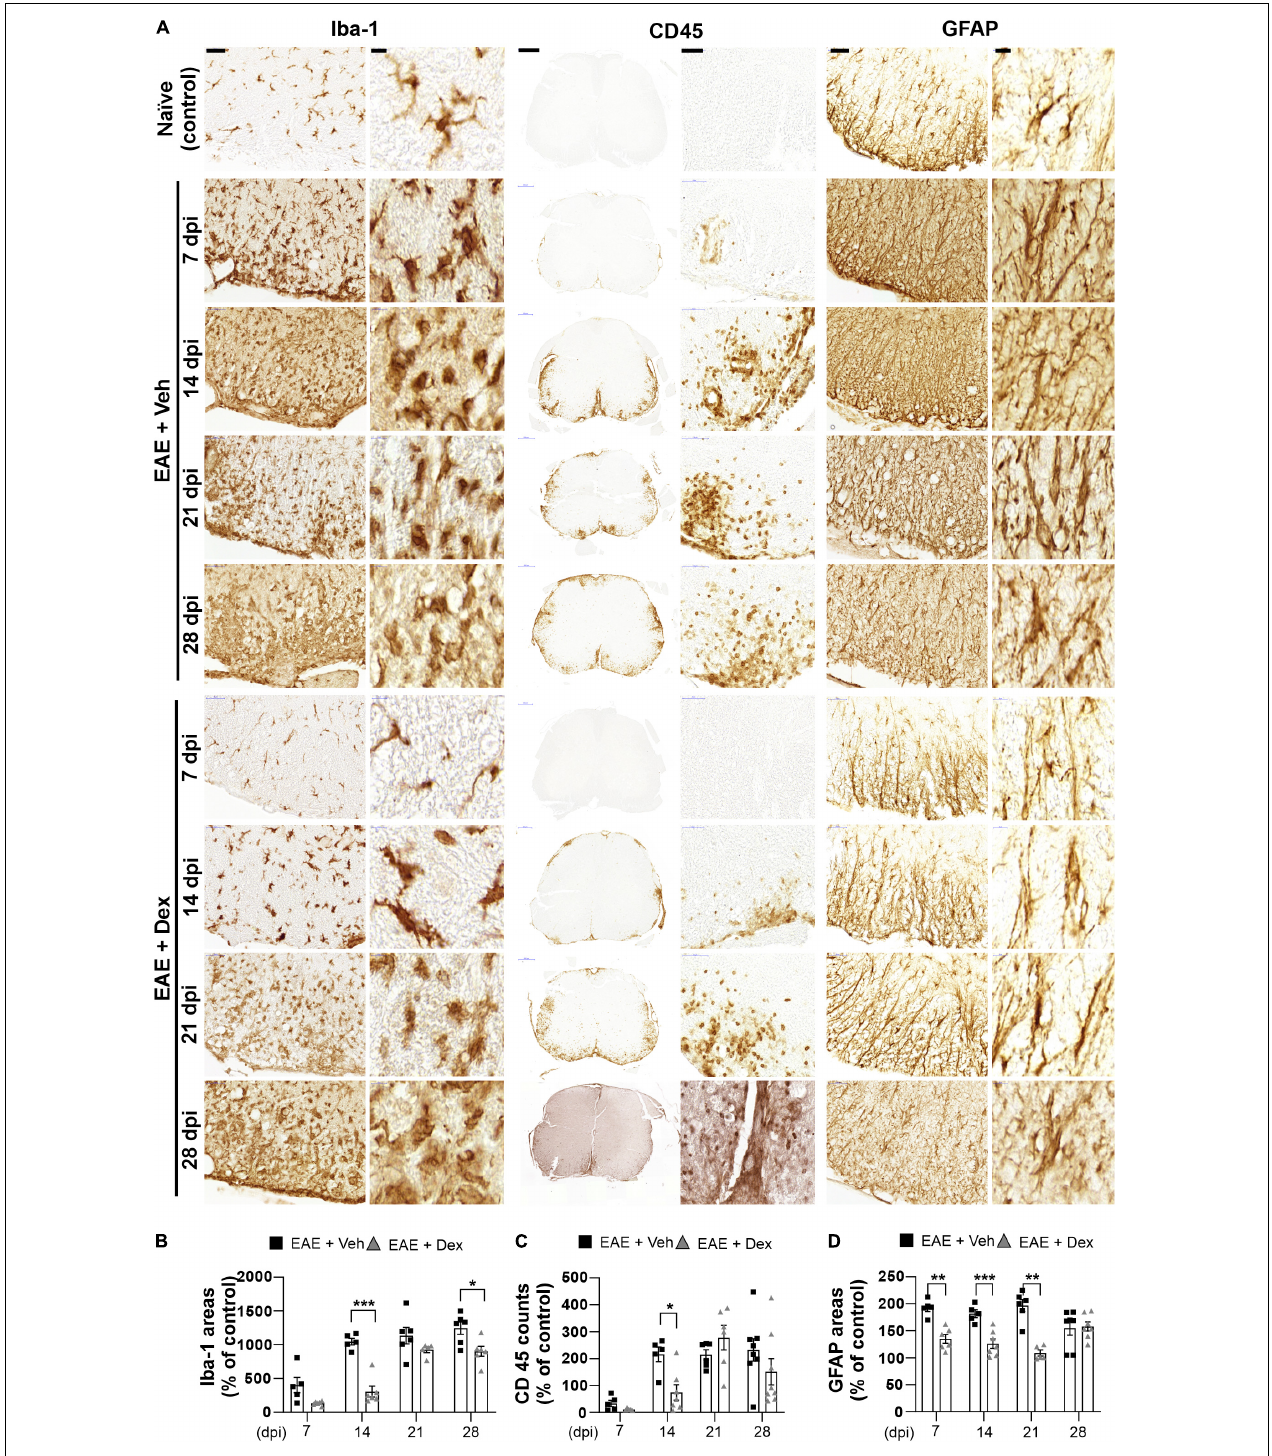
FIGURE 3 | Dexamethasone attenuated neuroinflammatory activation of microglia, leukocytes, and astrocytes during the early stage of EAE. (A) Representative images for Iba-1 (Left), CD45 (Center), and GFAP (Right) from immunostained mouse spinal cords at 7, 14, 21, and 28 dpi. (B) Quantification of Iba-1 area in each time point. * P < 0.05, and *** P < 0.001, Mean ± SEM. n = 5–6 per each group. (C) Quantification of the number of CD45-positive cells in each time point. * P < 0.05, and ** P < 0.01, Mean ± SEM. n = 5–8 per each group. (D) Quantification of GFAP area in each time point. ** P < 0.01, and *** P < 0.001, Mean ± SEM, n = 5–7 per each group. (B–D) 2-way ANOVA followed by Sidak‘s post hoc test for multiple comparisons. Scale bars: 200 µ m for CD45; 50 µ m for Iba-1, GFAP; 10 µ m for enlarged Iba-1, GFAP and CD45. Data from 4 repeated experiments.